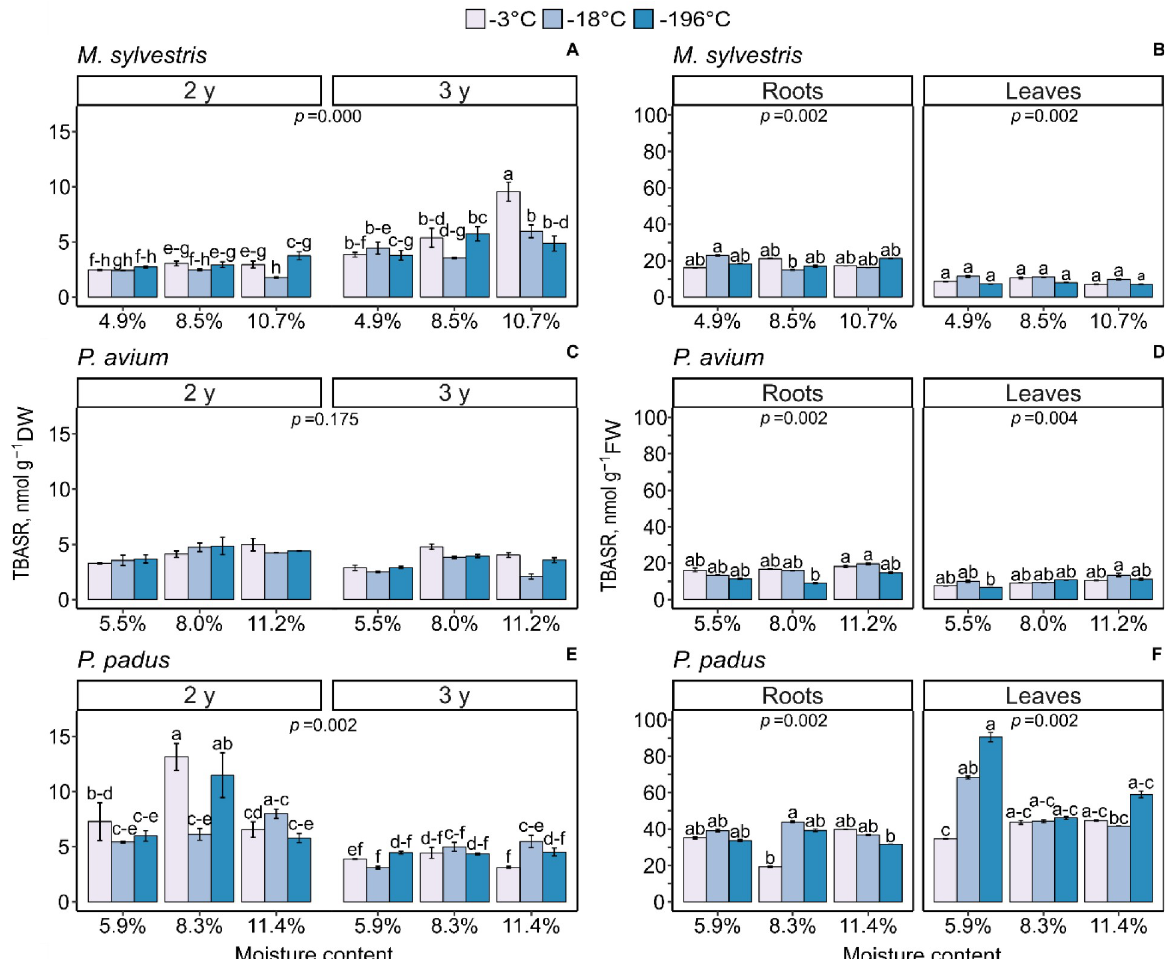
Fig 2. Changes in the levels of thiobarbituric acid reactive substances (TBARS) reported in germinated seeds (A, C, E) and 3-month-old seedlings derived from the seeds (B, D, F) of M . sylvestris (A, B), P . avium (C, D) and P . padus (E, F). In germinated seeds, the level of TBARS interaction between MC x storage temperature x storage time was compared. In 3-month seedlings, the level of TBARS was measured in leaves and roots. Data are the means ± standard error obtained from three independent experiments with similar results. Statistically significant differences are indicated with different letters among the groups, followed by Tukey’s test for germinated seeds and Dunn’s test for seedlings at p � 0.05.